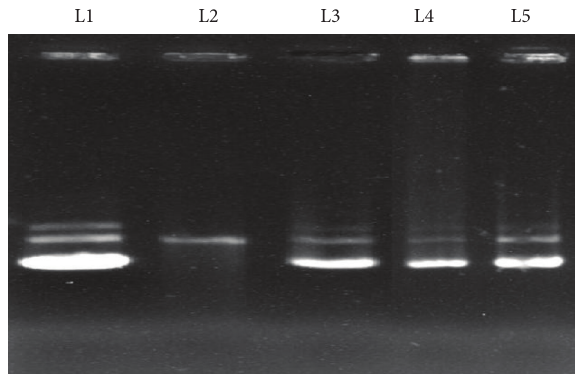
Figure 2: Protective effect of EAF on pUC19 plasmid DNA damage induced by AAPH. Lane 1: native DNA; Lane 2: DNA+AAPH; Lane 3: DNA +AAPH+30 μ g EAF; Lane 4: DNA +AAPH+20 μ g EAF; Lane 5: DNA+ AAPH+30 μ g gallic